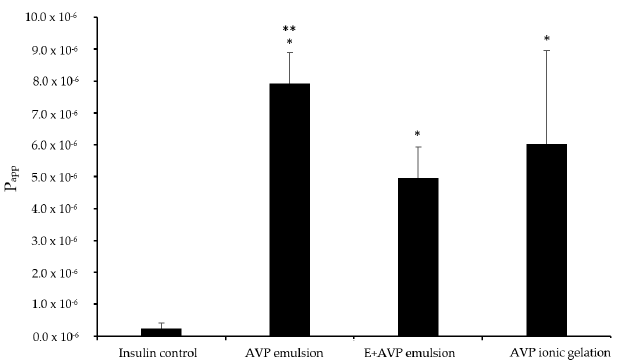
Figure 4. Apparent permeability coefficient (P app ) values for insulin across excised respiratory sheep nasal epithelial tissues after application of the microparticle formulations and insulin alone (control group). AVP emulsion = insulin microparticle formulation prepared by emulsion-solvent evaporation consisting of A. vera polysaccharides only, E + AVP emulsion = emulsion-solvent evaporation with Eudragit ® L100 and A. vera polysaccharide, and AVP ionic gelation = ionic gelation with A. vera polysaccharide only. * Statically significantly different from the control group ( n = 6; p < 0.05). ** Statistically significant difference between AVP emulsion group and E + AVP emulsion